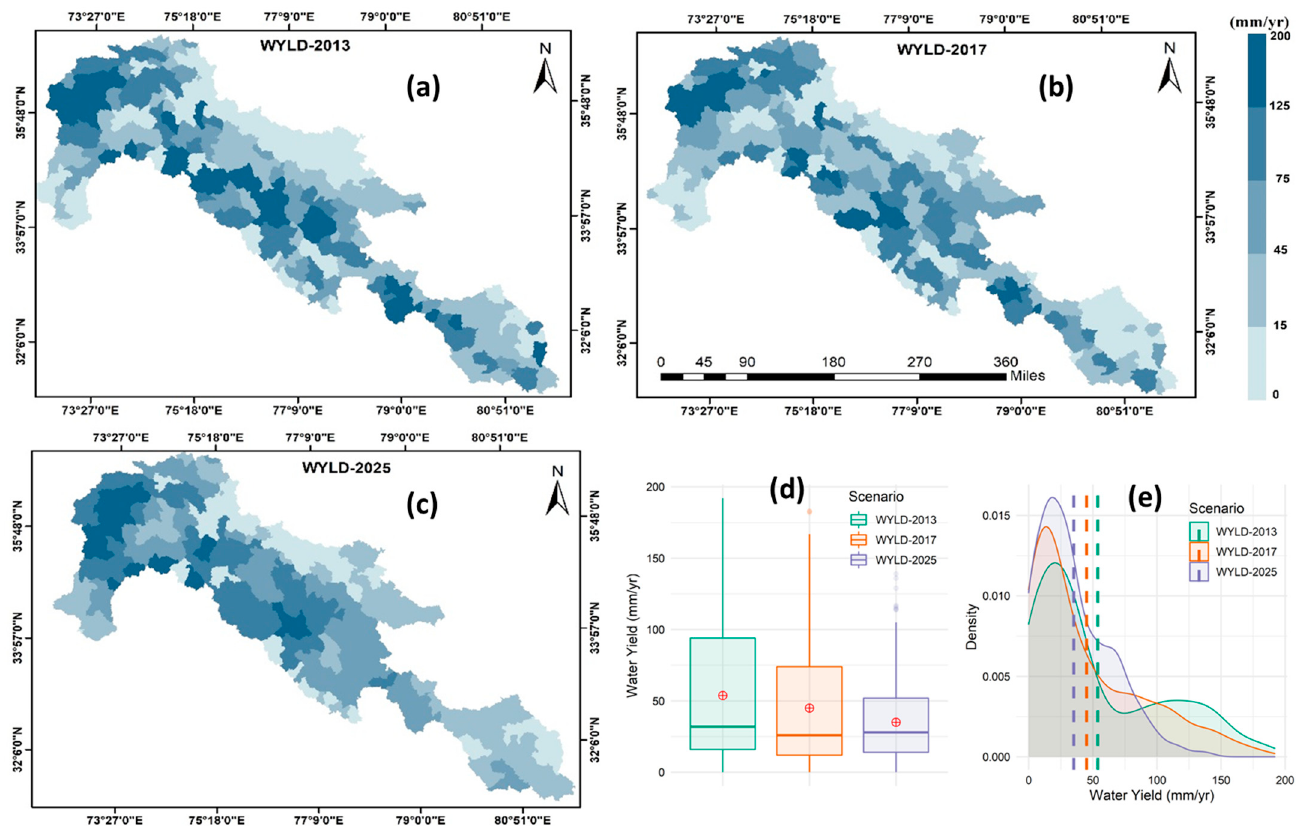
Figure 6. Spatial distribution of the water yield for three scenarios ( a ) 2013, ( b ) 2017, and ( c ) 2025 in the sub-basins. ( d ) boxplots and ( e ) density distribution plots to present differences among the scenarios. Table 4. Analysis of variance (ANOVA) test and Tukey’s honestly significant difference (Tukey’s HSD) post hoc test for pairwise comparisons of the water yield under different scenarios. Sum of squares (SS) Degrees of freedom (df)